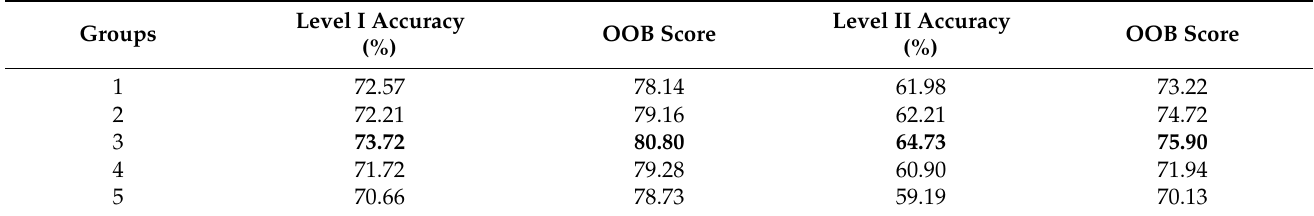
Table 7. Sample size and feature classification results for each experimental group. The bolded content is the best performed.